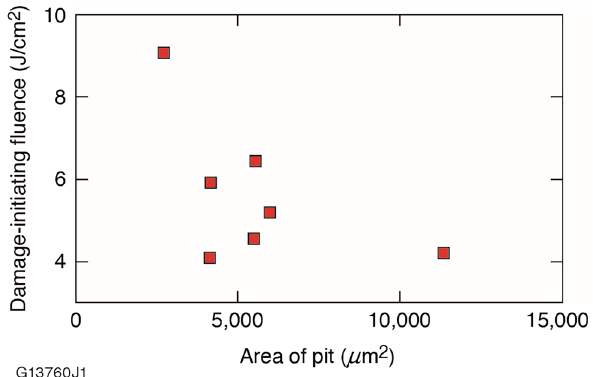
Figure 6. The R -on-1 damage-initiating fluence versus fracture pit area for the seven largest fracture pits on the FJP-finished sample.